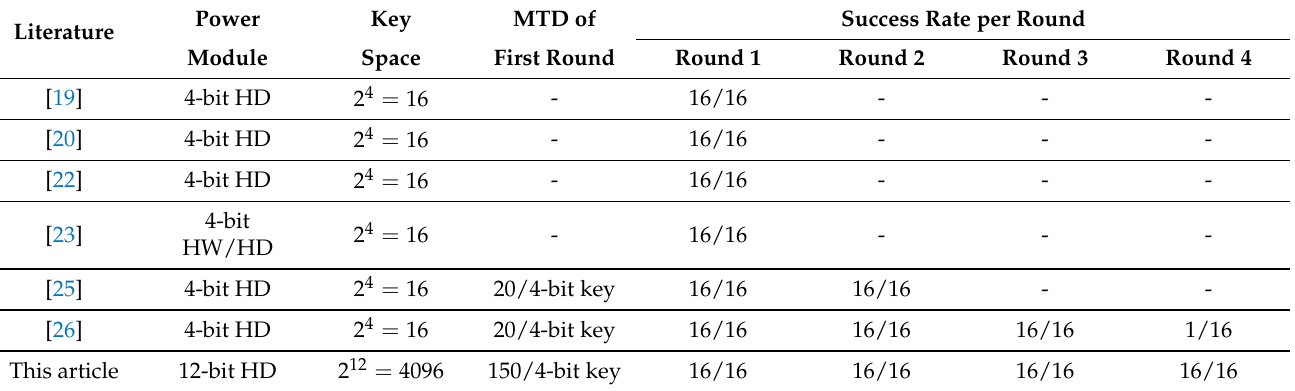
Table 7. Comparison with other